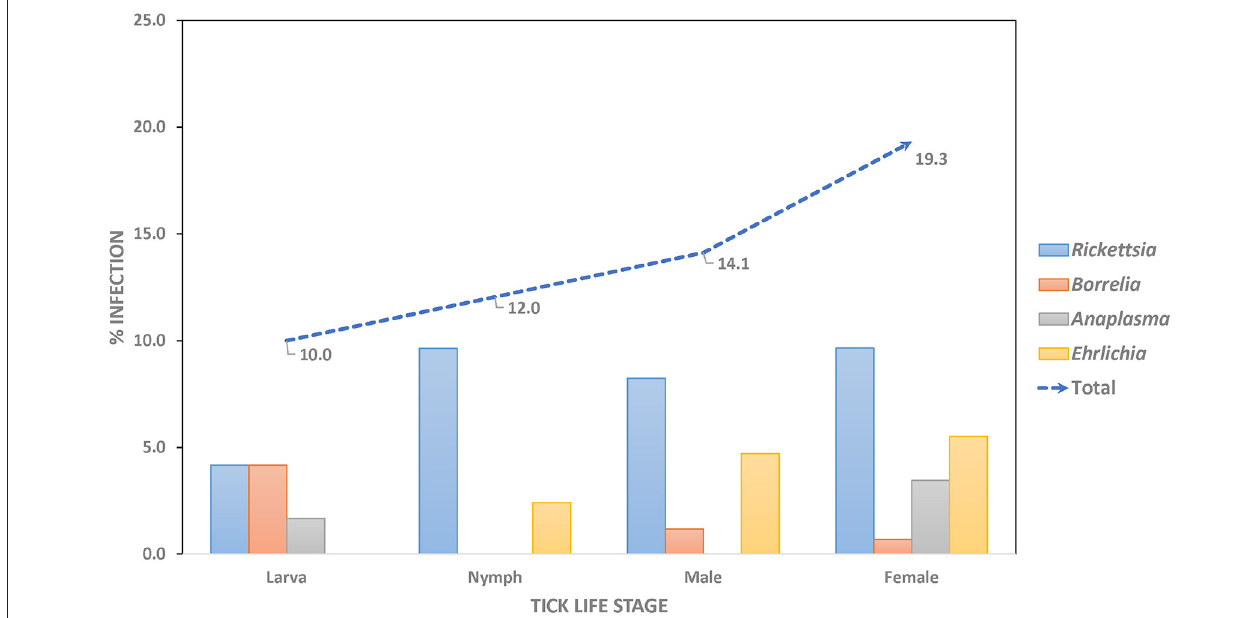
FIGURE 1 | Prevalence rate of pathogenic bacteria in questing ticks, by stages.